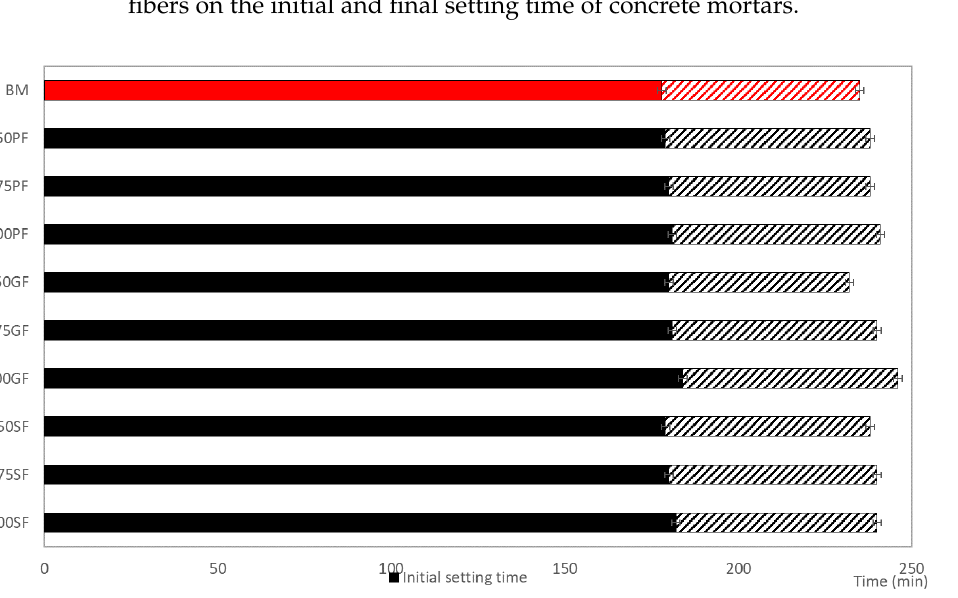
Figure 3. Initial and final setting time distribution of the tested mixtures: samples with fibers marked as black, BM marked as red.